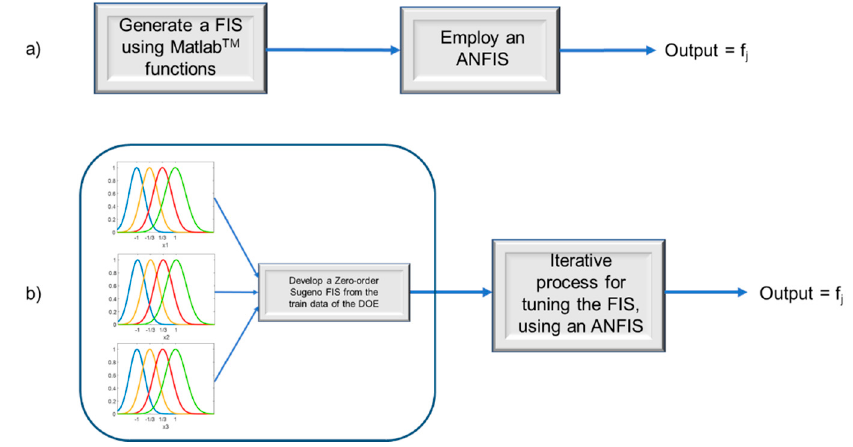
Figure 18. Strategies for obtaining an ANFIS for modeling f 1 and f 2 . ( a ) Using Matlab TM functions, ( b ) Proposed methodology.